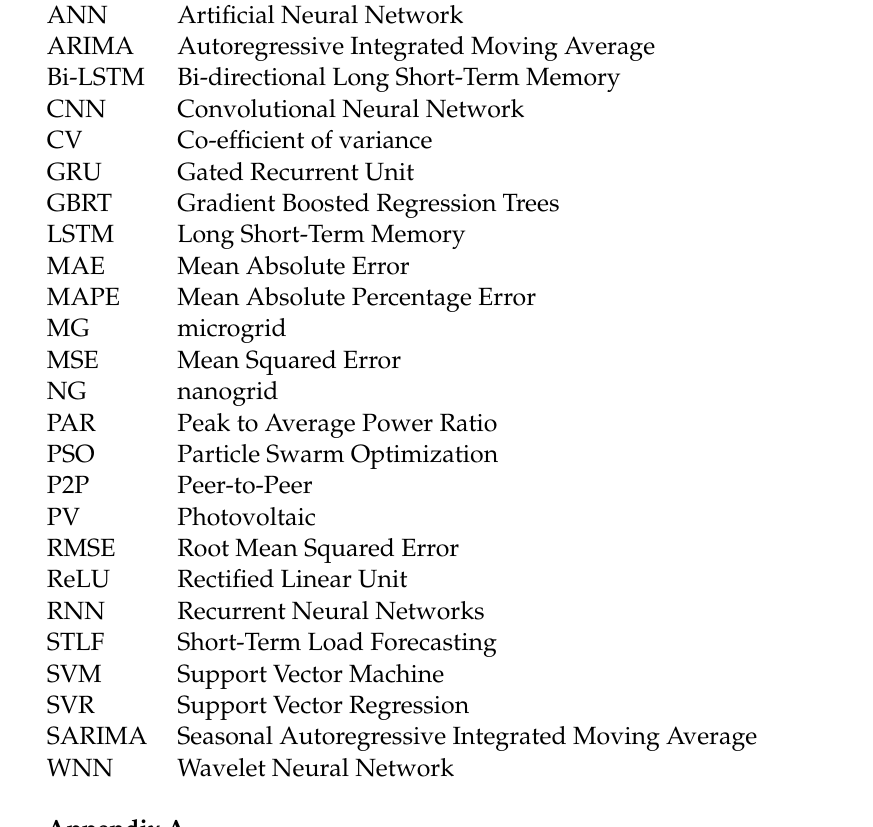
Hourly Load forecast for nanogrid Output